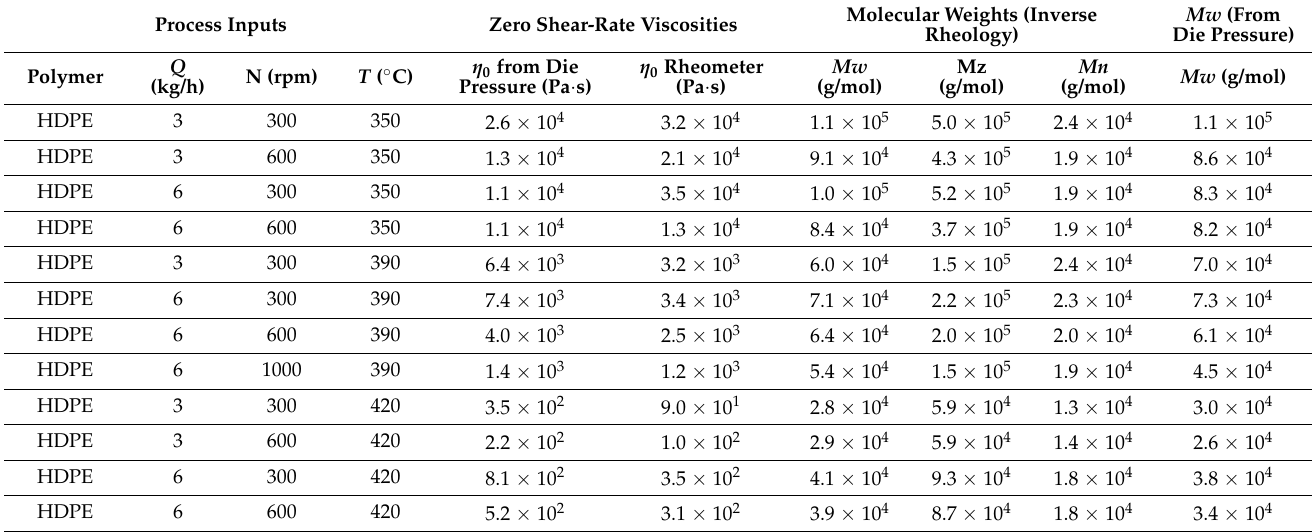
Table A3. Viscosities and molecular weights for the different tested extrusion